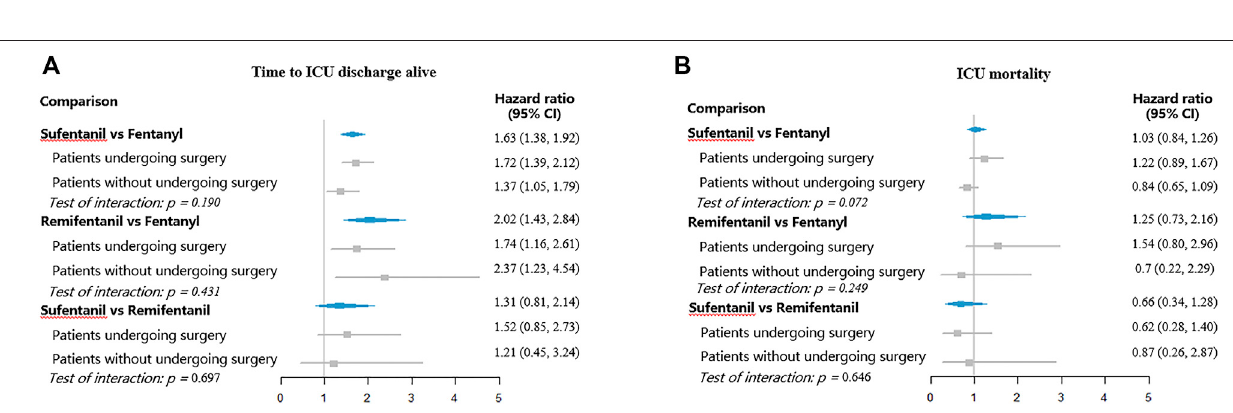
Frontiers in Pharmacology |